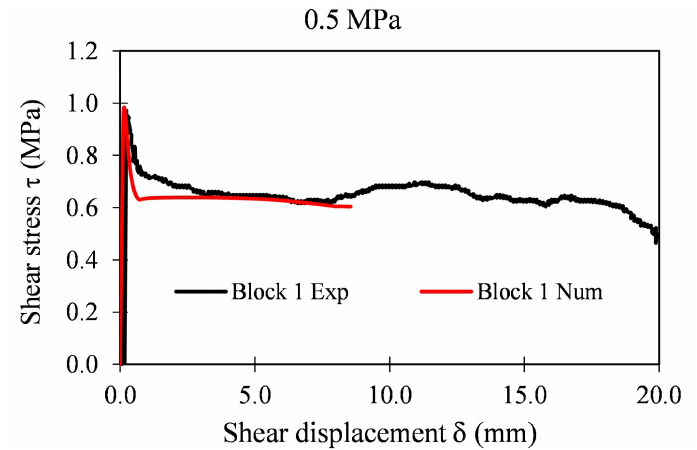
Figure 24. Shear stress evolution with displacement Exp–Num (Block